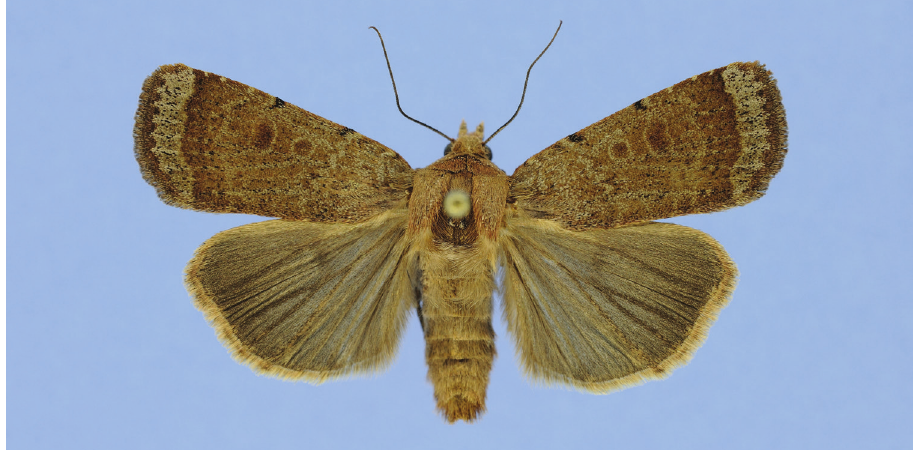
Figure 11. Abagrotis benjamini Franclemont, Dartmouth, MA, ex larva. M.W. Nelson. Other material examined. (not including ~13 with DNA barcodes pending) MASSACHUSETTS (28 ♂ , 18 ♀ ): Edgartown (1 ♂ , 2 ♀ ): Katama Plain 41°21.472'N, 70°31.256'W, 19 June 2010 (1 ♂ ); Wintucket Cove frost bottom 24 July 1991 (1 ♀ ); Felix Neck Wildlife Sanctuary 7 VII 1989 P.Z. Goldstein, leg. (1 ♀ ). Aquinnah (22 ♂ , 15 ♀ ): East Pasture Road, 41°20.494'N, 70°47.248'W, @ UV Trap: 30 June 2013 (1 ♂ , 1 ♀ ); 1 July 2011 (1 ♂ ); 15 July 2011 (1 ♂ ); off Moshup Trail/E. of Moshup Trail, 41.324894, -70.810698 / 41°19'29.6'N, 70°48'38.5'W (7 ♂ , 7 ♀ ): 17 vii 2003 (3 ♂ , 1 ♀ ) [USNM Dissection #s 148015 ♂ ; 148029 ♂ (Fig. 23); 148031 ♂ ]; 17 July 2015 (1 ♀ ) Barcode of Life DNA voucher specimen SampleID CCDB-28975-E01 BOLD Proc ID LNAUU 1474-15; USNM Dissection #148022 ♀ ; 31 July 2014 (1 ♀